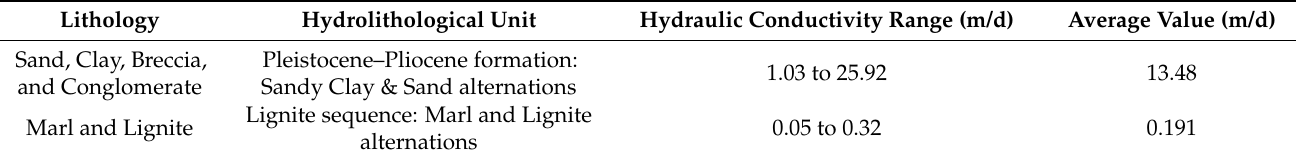
Table 3. Hydrolithological units based on the lithological